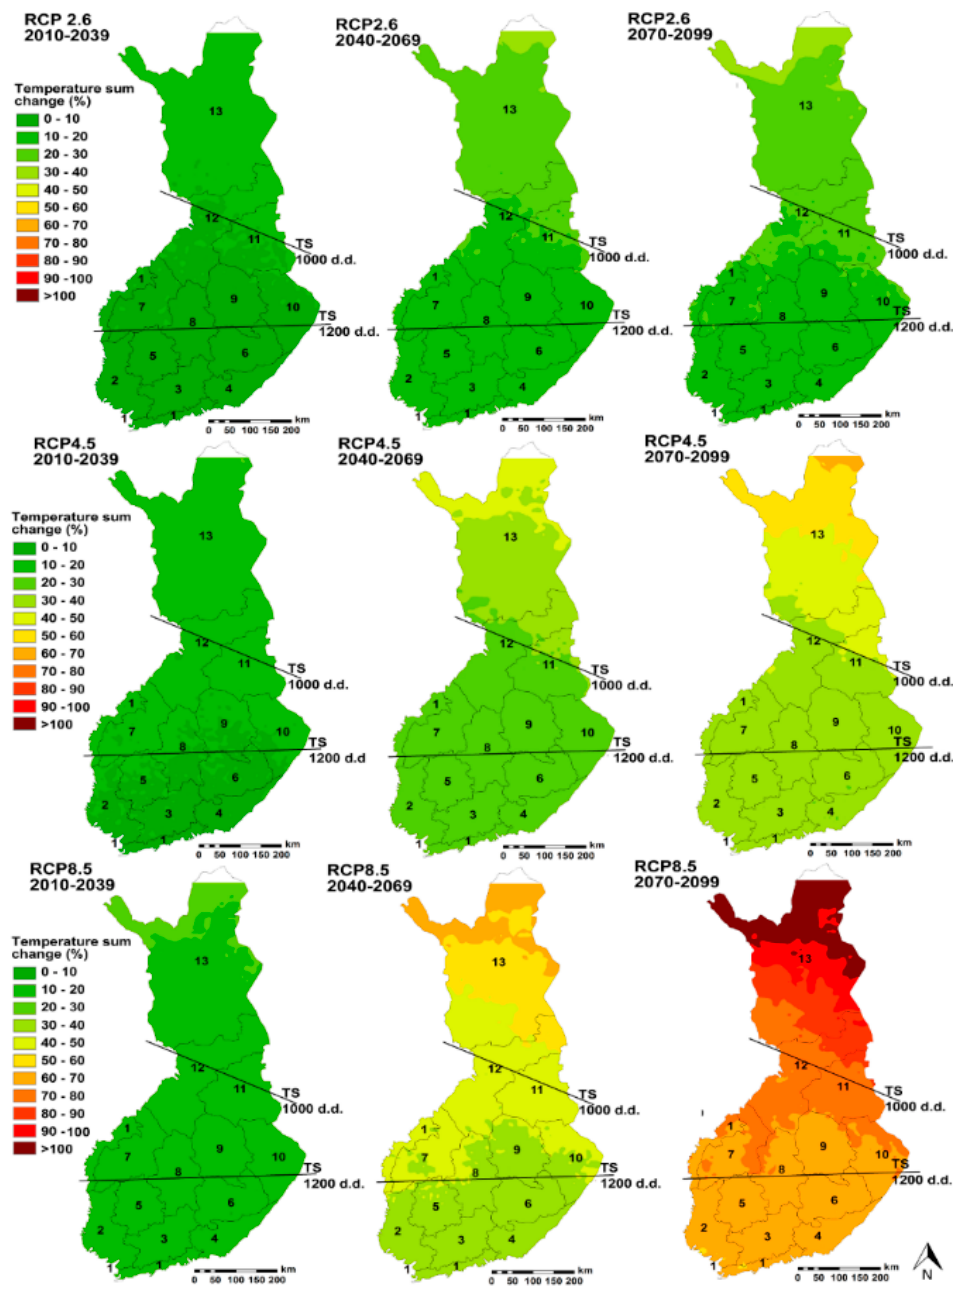
Figure 1. Predicted changes in temperature sum (TS) under the minor (RCP2.6), moderate (RCP4.5), and severe (RCP8.5) climate change scenarios for the sub-periods 2010–2039, 2040–2069, and 2070–2099. The temperature sum lines across the country separate the southern (TS > 1200 d.d.), central (1000 d.d. < TS < 1200 d.d.), and northern (TS < 1000 d.d.) boreal regions.